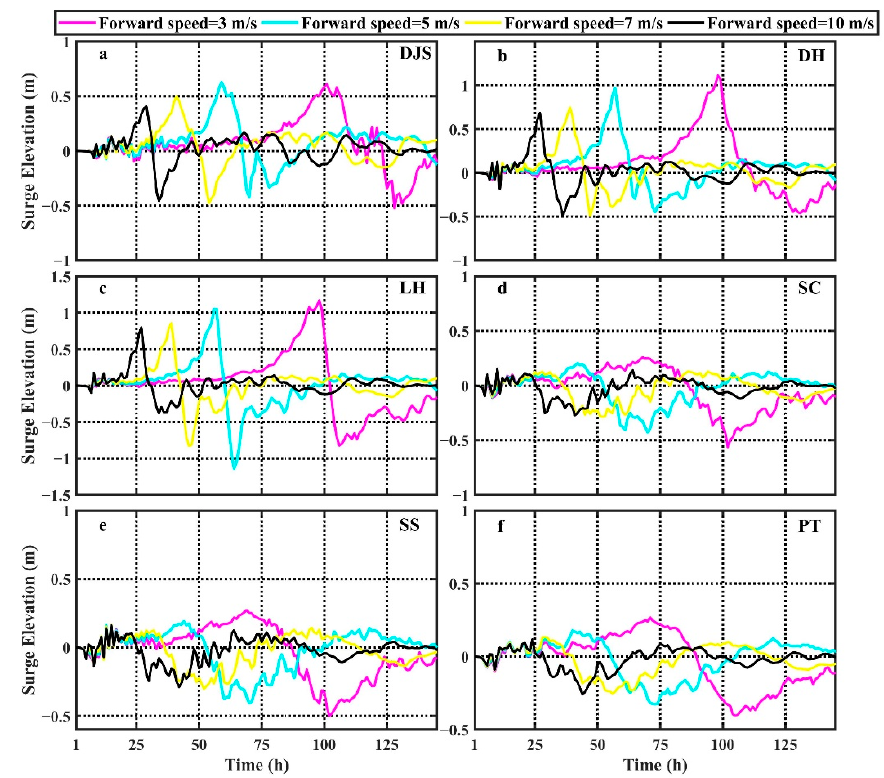
Figure 5. Time series of surge elevation in experiments with different forward speed at stations: ( a ) DJS, ( b ) DH, ( c ) LH, ( d ) SC, ( e ) SS, and ( f )